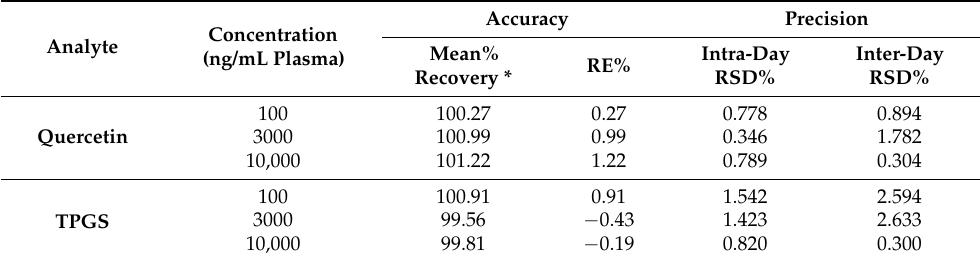
Table 4. Accuracy and precision evaluation of the proposed method.